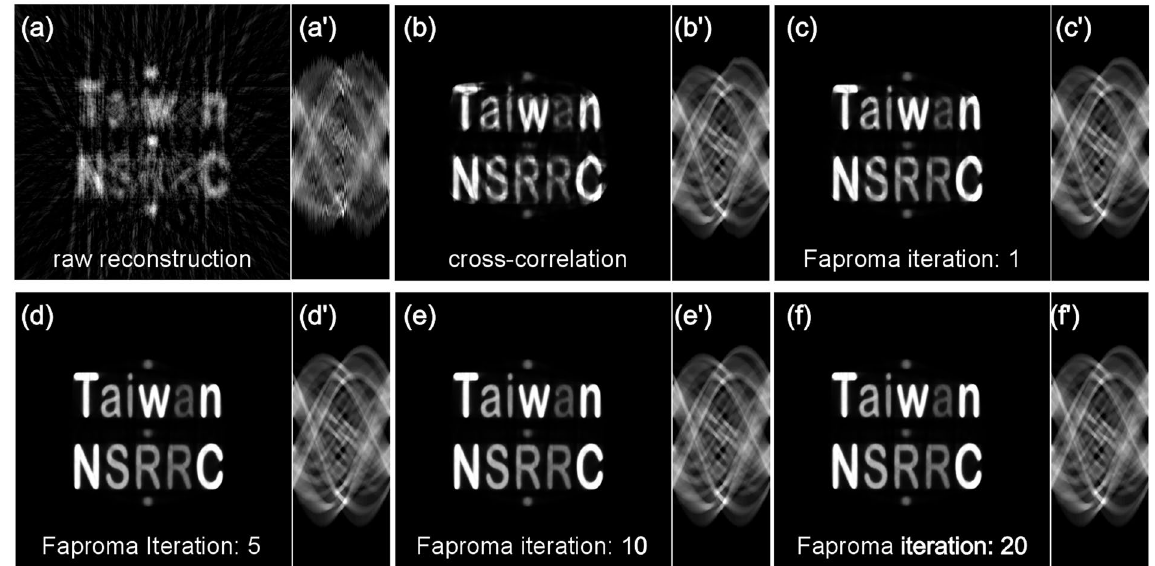
Figure 4. Demonstration of the second correction process using a computer-generated 3D phantom as shown in Fig. 3a and a’. ( a ) and (a’) are the selected reconstruction layer and its corresponding sinogram of the raw artificial projections, which were pre-corrected using the Faproma’s first correction process, respectively. ( b ) and (b’) are the layer reconstruction and corresponding sinogram after cross-correlation correction. ( c – f ) Are layer reconstruction results after 1, 5, 10, and 20 iterations of correction using the Faproma’s second correction process. (c’–f’) are the corresponding sinograms of ( c–f